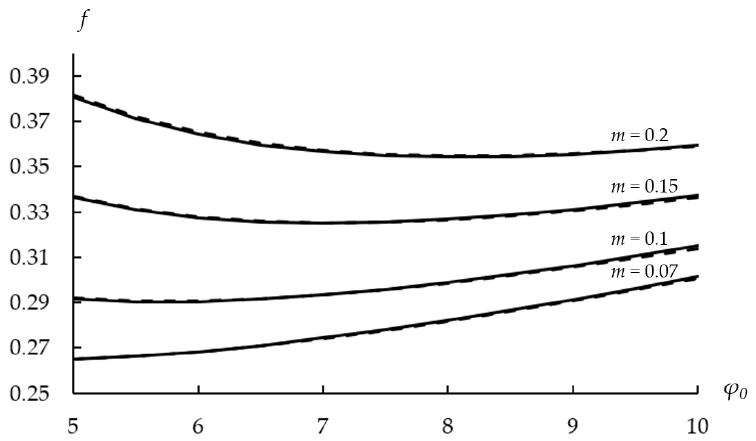
= 1.07 and = 1.07 and R 2 (cid:3019) (cid:3118)